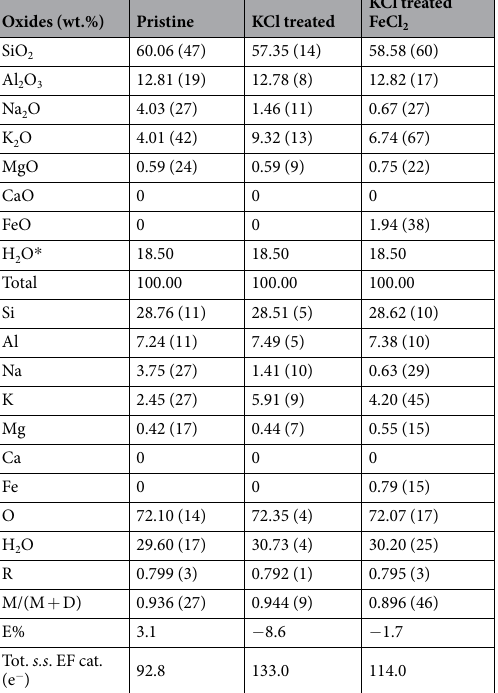
Table 1. Chemical analyses, by SEM-EDS, of both pristine 16 and KCl treated fibres (3 cycles). Standard deviations are reported in parenthesis. * Estimated.